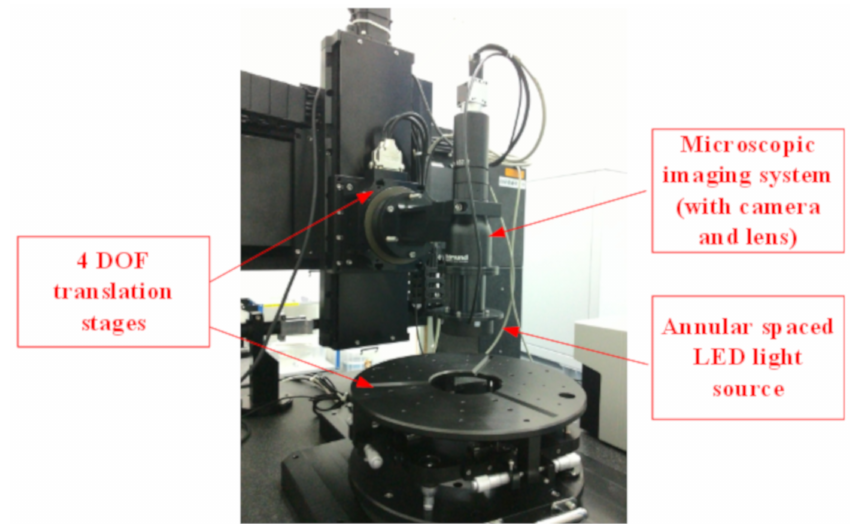
Figure 15. Dark-field defect inspection system with four-degree-of-freedom (4-DOF) translation stage, annular spaced LED light source and microscopic imaging system.